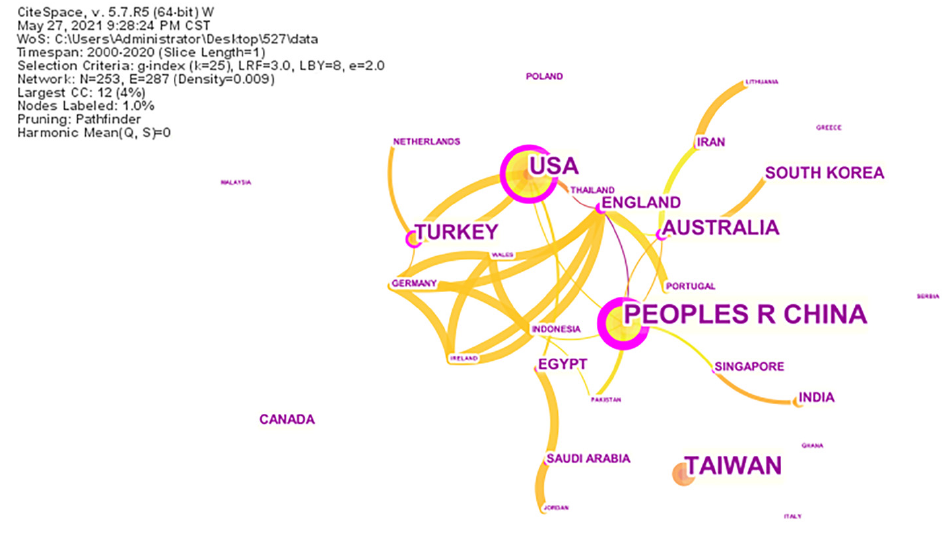
Figure 3. Collaboration network of countries/regions in the research on ANN in CM.